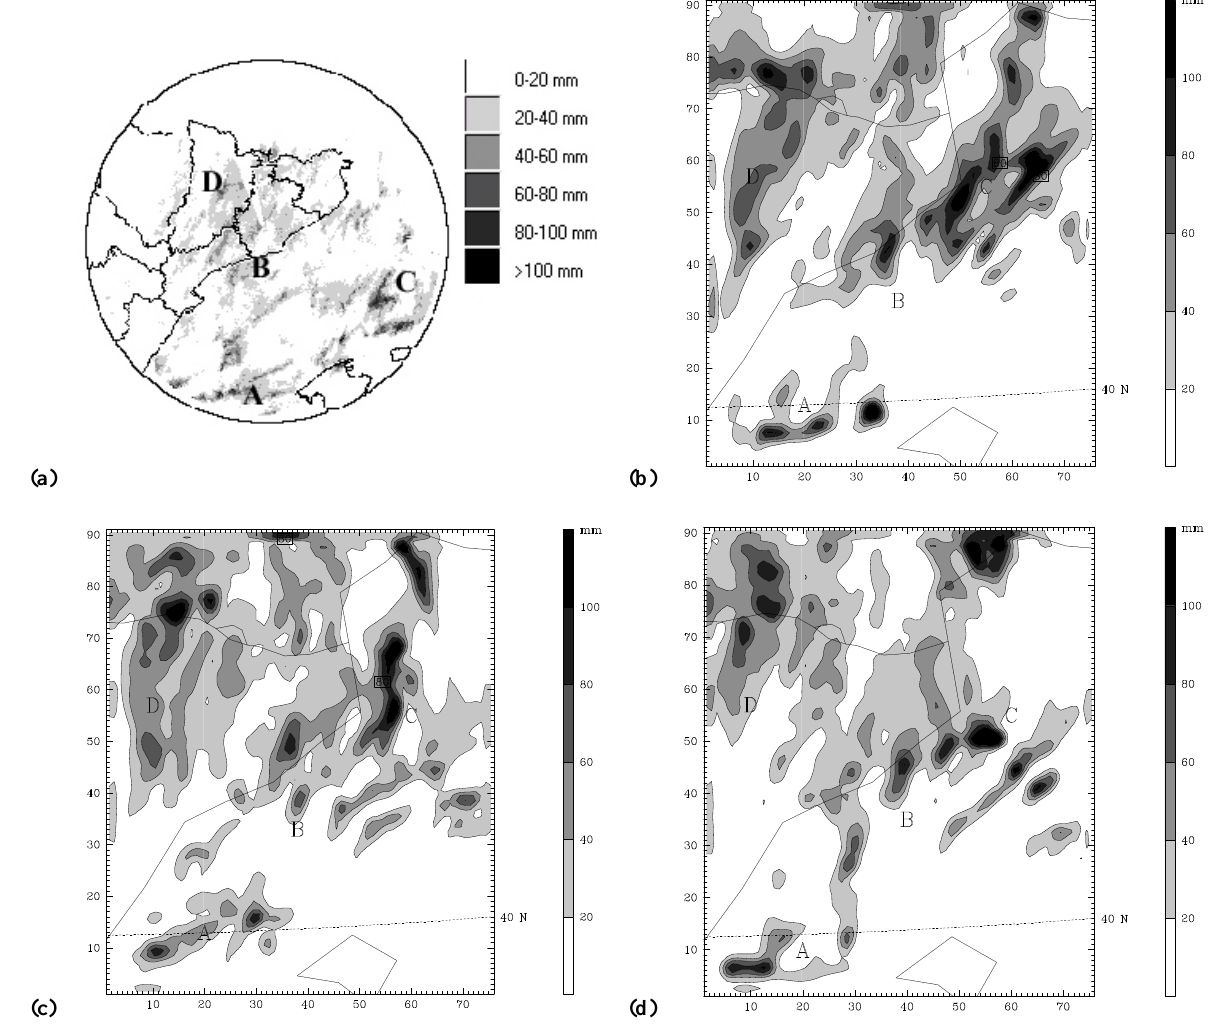
Fig. 9. 24-h accumulated precipitation for 14 September 1999. The most significant precipitation areas are indicated by the letters A, B, C and D. The panels correspond to the following observations and simulation: (a) Radar, (b) MRF, (c) BLA, (d)